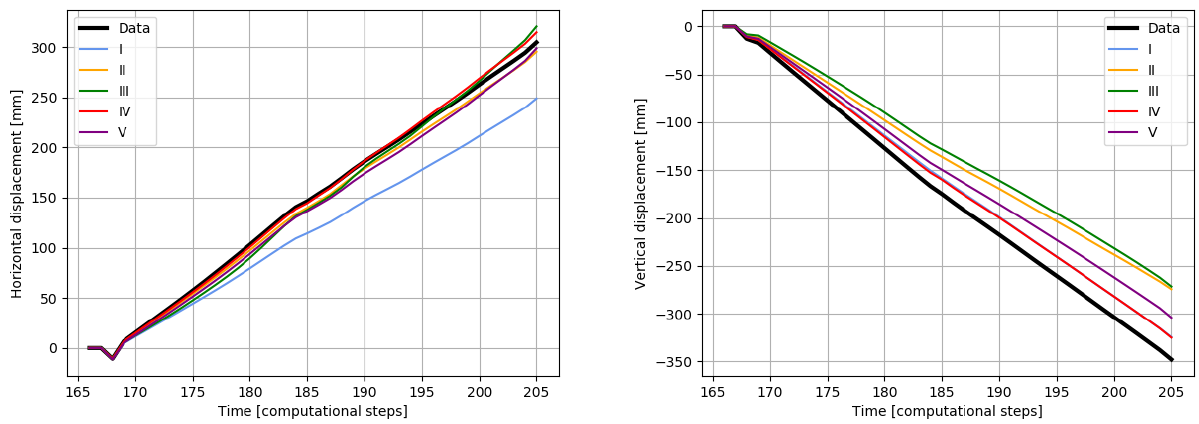
Figure 11: Results of horizontal (left) and vertical (right) displacement in benchmark U3.